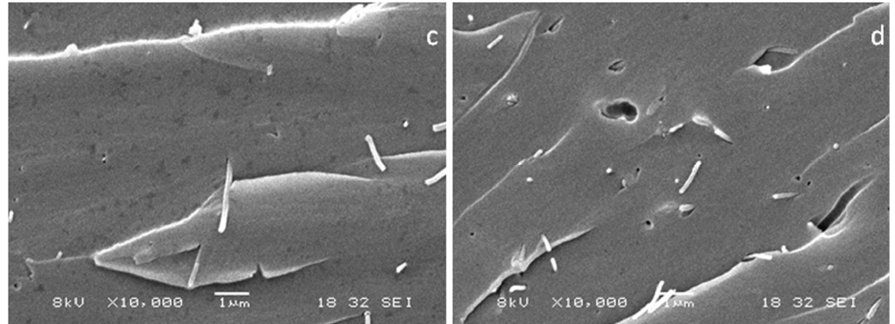
Figure 14. SEM micrograph of different fracture surfaces. ( a ) Crack initiation site 1 wt % D-CNF epoxy; ( b ) fast fracture site of 1 wt % D-CNF epoxy; ( c ) crack initiation site of 1 wt % V-CNF epoxy; and ( d ) fast fracture site of 1 wt % V-CNF epoxy.